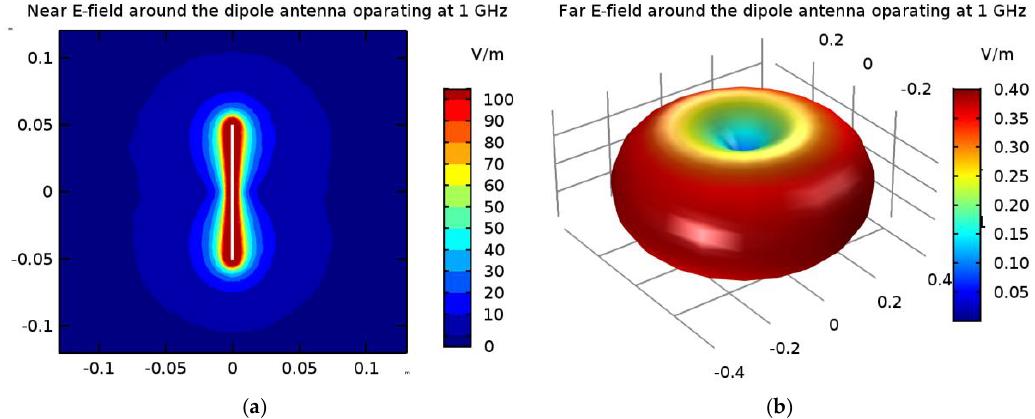
Figure 13. The electric field derived from the 1-GHz half-wave dipole antenna with a shortening ratio set at k s = 0.67: ( a ) near field distribution; ( b ) far field radiation.